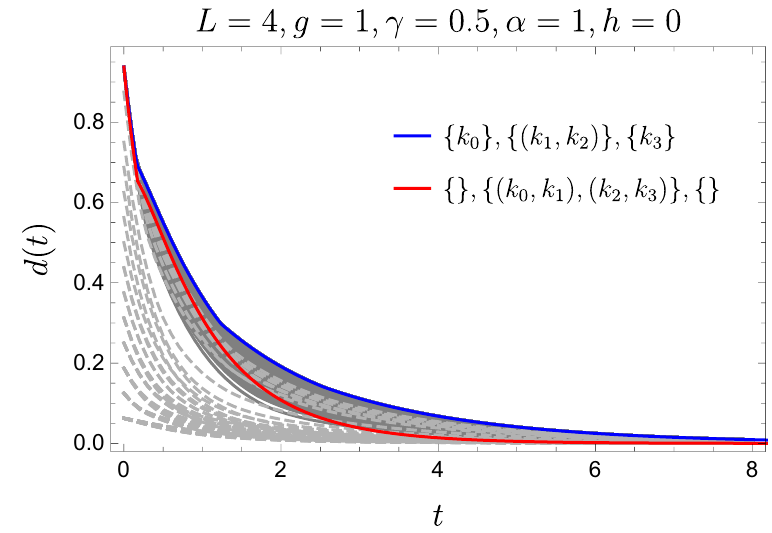
Figure 5: Evolution of the distance to equilibrium in the gain / loss model for L = 4. The dashed light gray lines correspond to randomly drawn initial density matrices with various levels of mixing, while the darker gray lines correspond to initial pure quantum states. The colored lines are analytical predictions for initial density matri- = 2 π j ces of the type (46). We recall the notation k for the momenta, but emphasize j L that in the present case the results are insensitive to any permutation of the